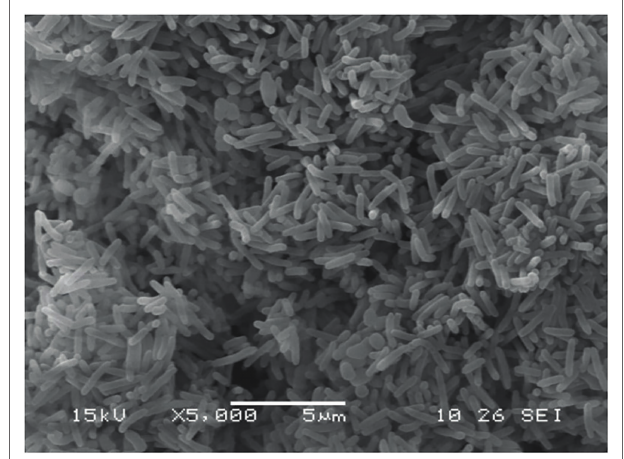
FIGURE 1 | The morphology of Pseudomonas mosselii K17. Observed by scanning electron microscope